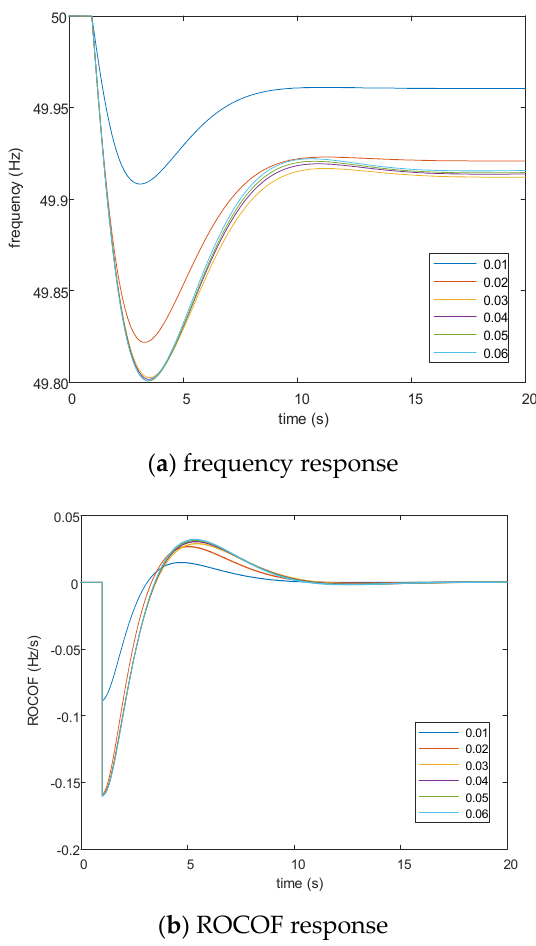
Figure 18. Dynamic responses with adaptive parameter tuning.